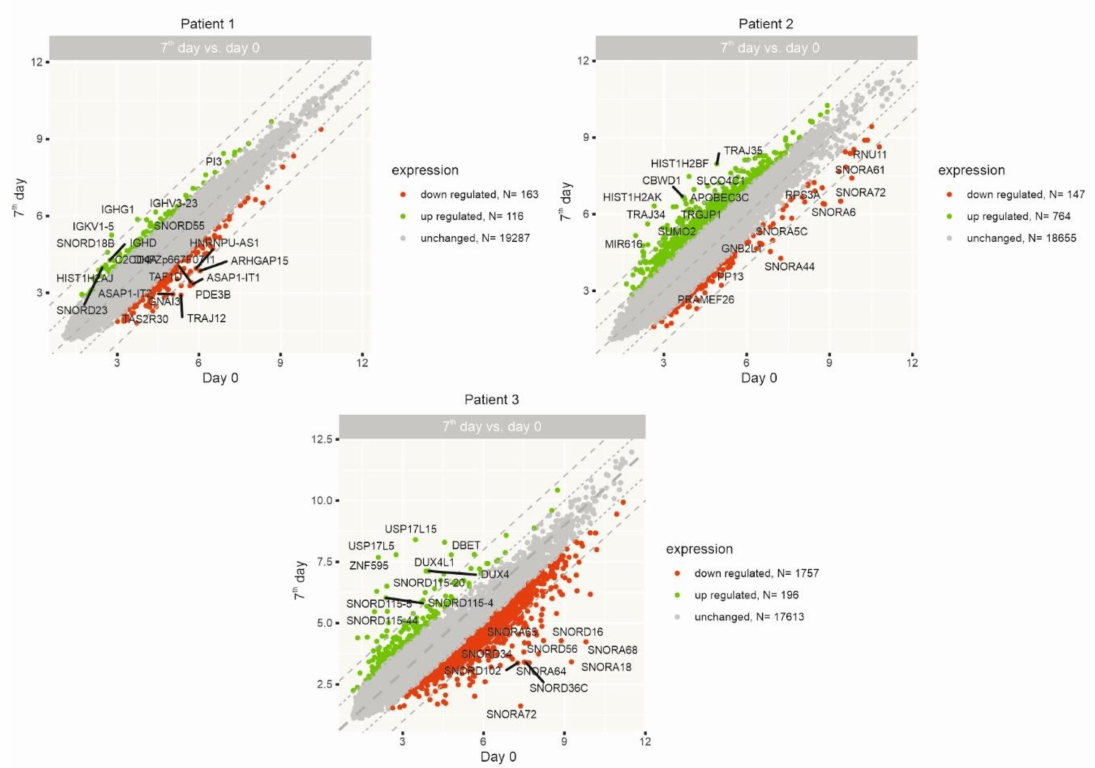
Figure 3. Scatter plots representing the most up- (green) and down-regulated (red) genes on the seventh day after Lin − cells injection in comparison to day zero for each individually analyzed